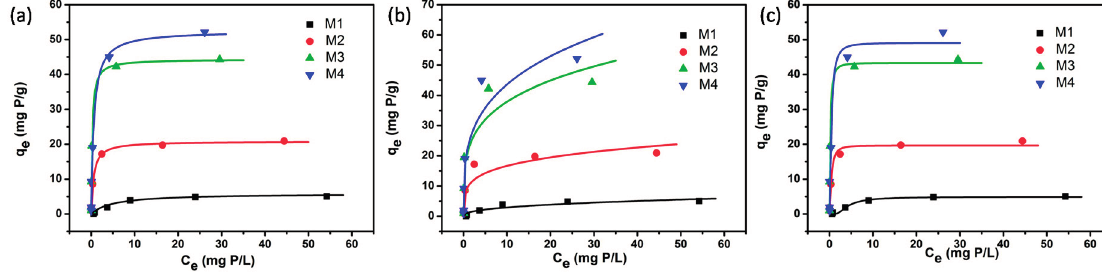
Figure1. Non-linear fitting of ( a ) Langmuir, ( b ) Freundlich, and ( c ) Dubinin-Radushkevich isotherm models for the four adsorbents (M1, M2, M3 and